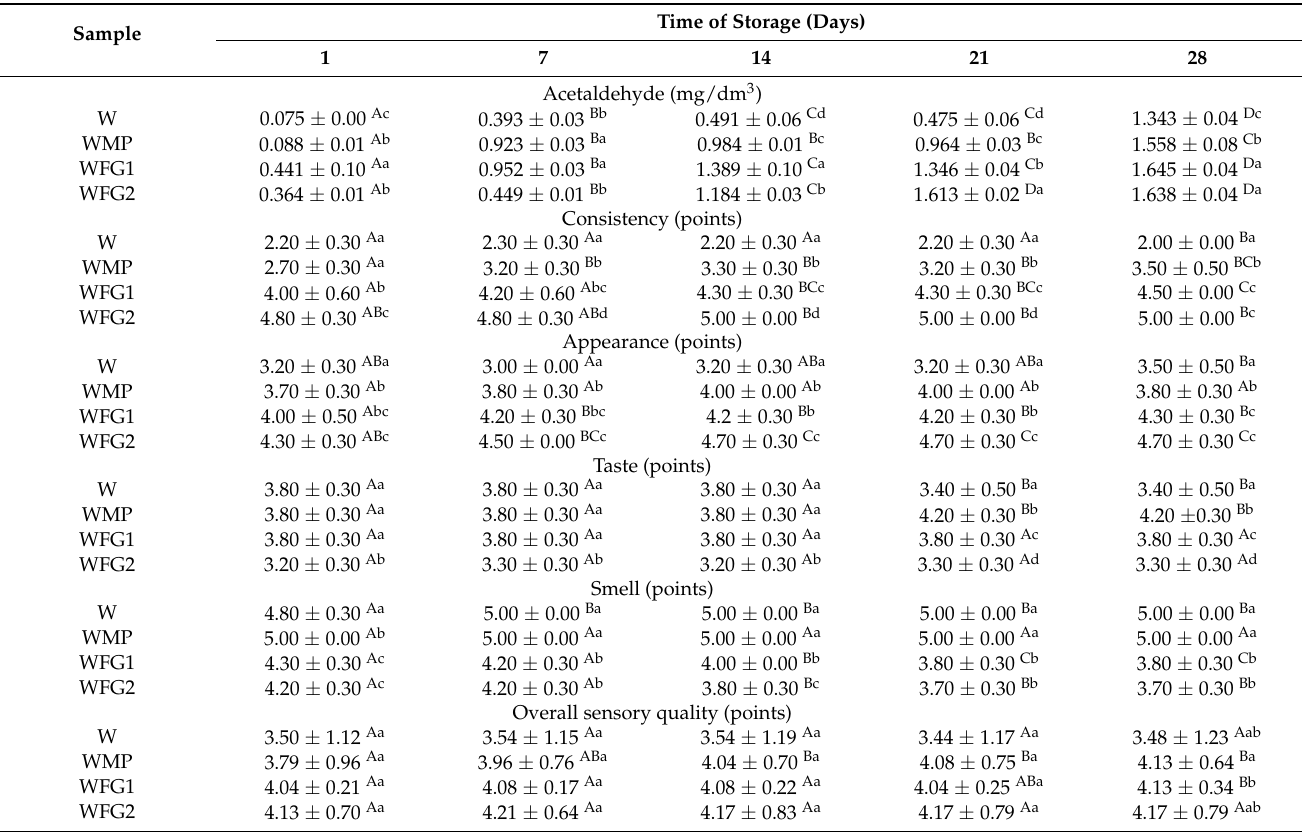
Table 4. Changes in acetaldehyde content and sensory evaluation